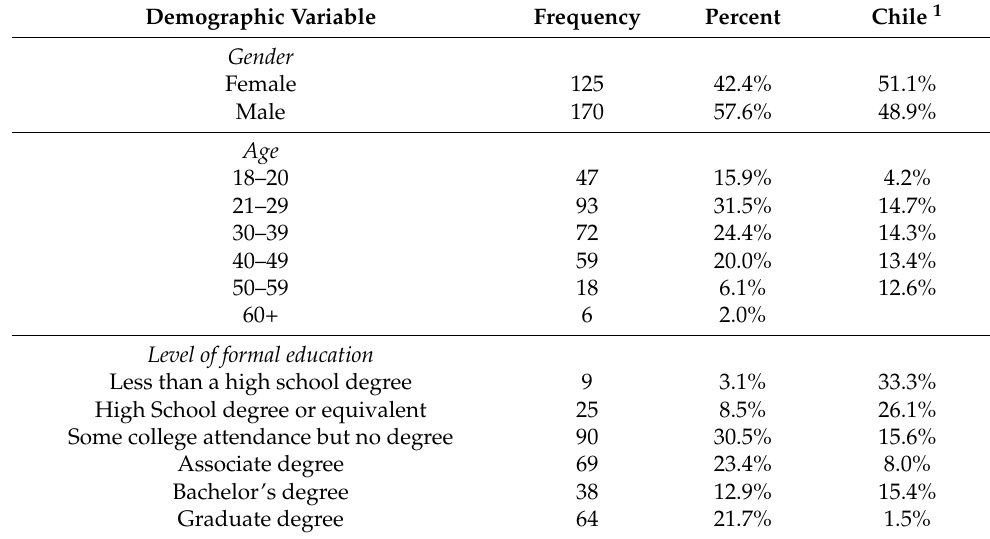
Table 1. Demographics.